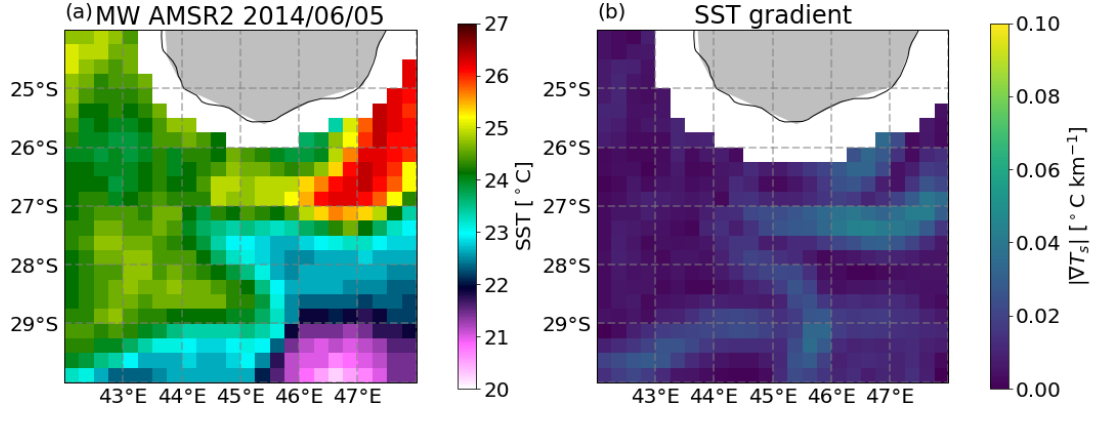
Figure A2. ( a ) SST captured by AMSR2 on the 5 June 2014, same date than SST shown in Figure 4 ( b ) Sobel gradient of SST captured by